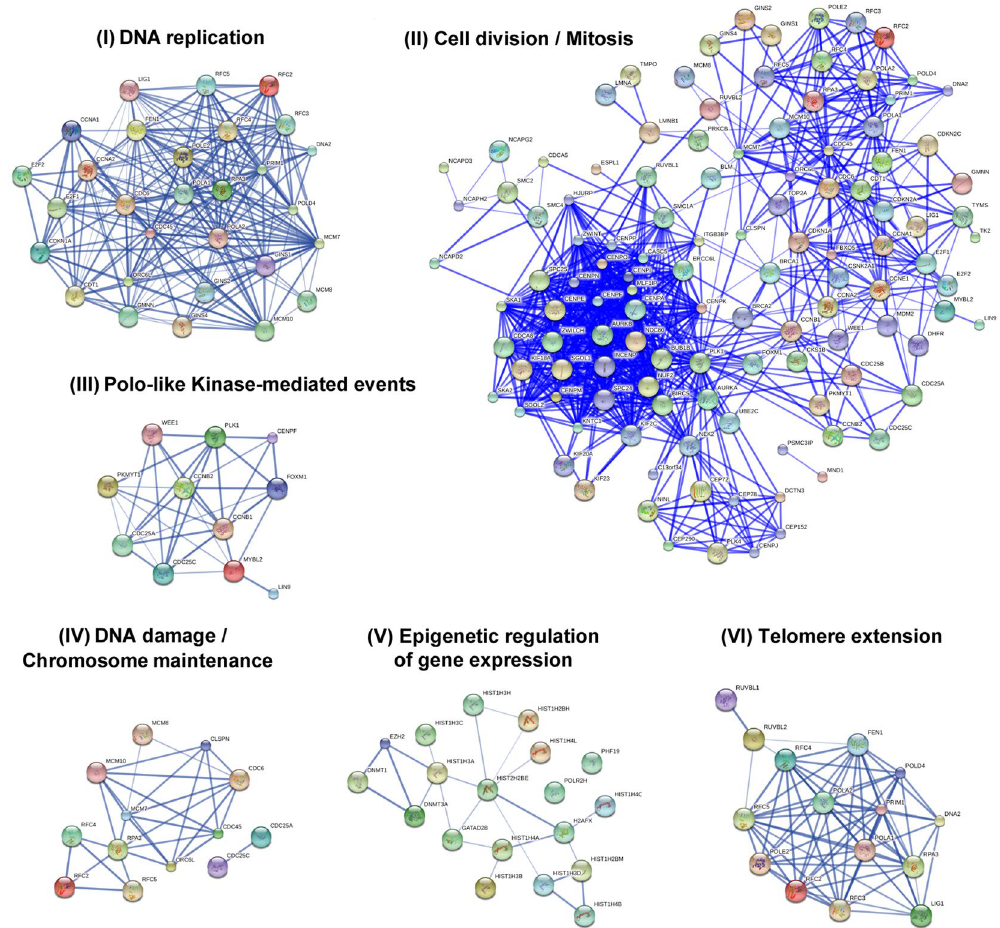
Figure 5. HIV-1 replication induces a rapid modulation of genes involved in DNA- and chromatin-related events. Complex DNA- and chromatin-associated signaling networks are strongly modulated in HSApos MØ at 36 hpi for the following enriched GO-terms: DNA replication ( I ), cell division and mitosis ( II ), Polo-like kinase-mediated events ( III ), DNA damage and chromosome maintenance ( IV ), epigenetic regulation of gene expression ( V ) and telomere extension ( VI